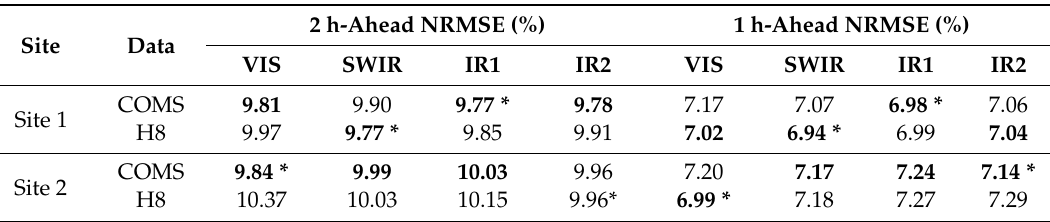
Table 9. NRMSE results from PV forecast for COMS and H8 datasets using the DNN model (bold text indicates the lower NRMSE value between COMS and H8 while the asterisk emphasizes the lowest NRMSE values for each dataset per site).